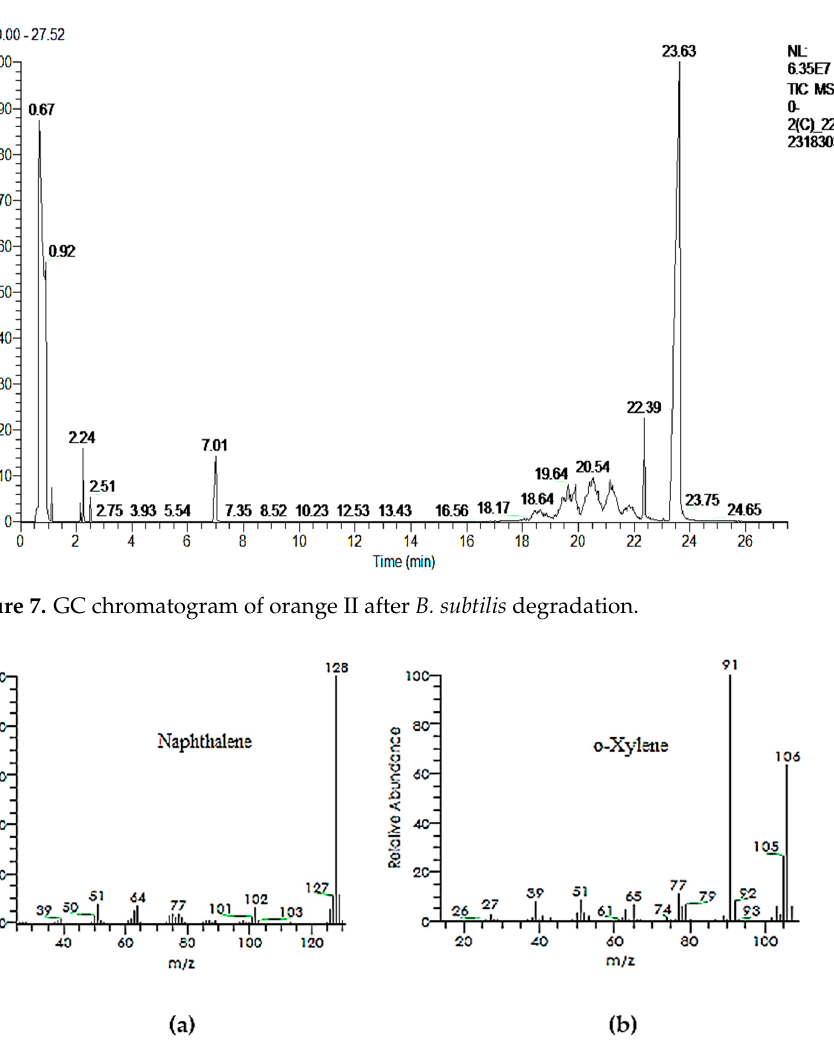
Figure 8. ( a , b ) GCMS chromatograms of two important metabolites.